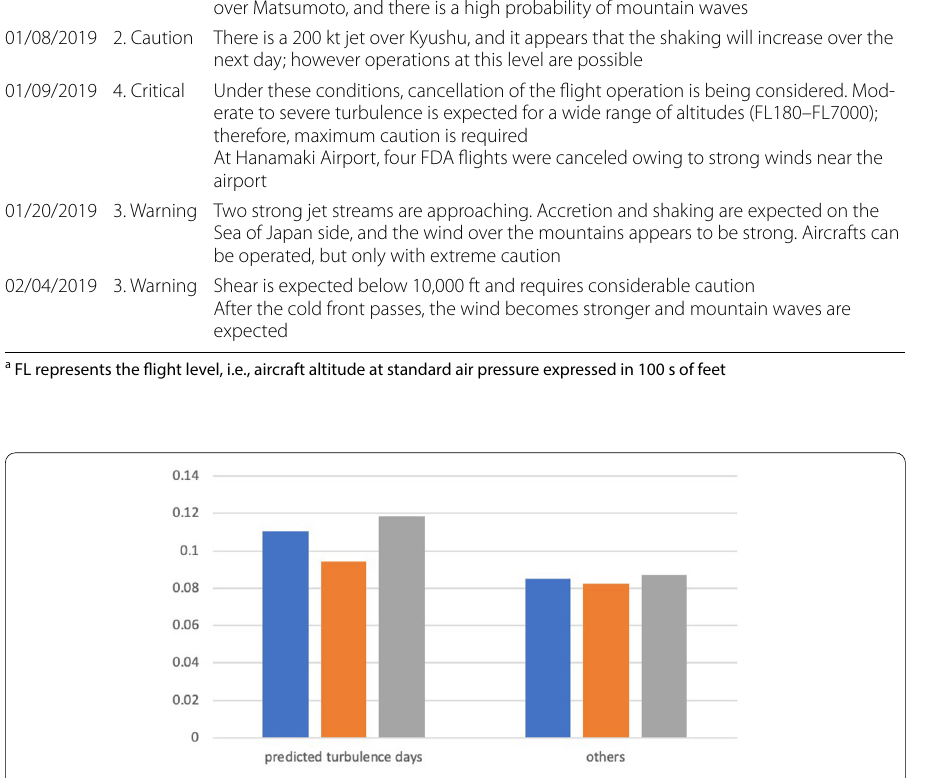
01/08/2019 2. Caution There is a 200 kt jet over Kyushu, and it appears that the shaking will increase over the next day; however operations at this level are possible 01/09/2019 4. Critical